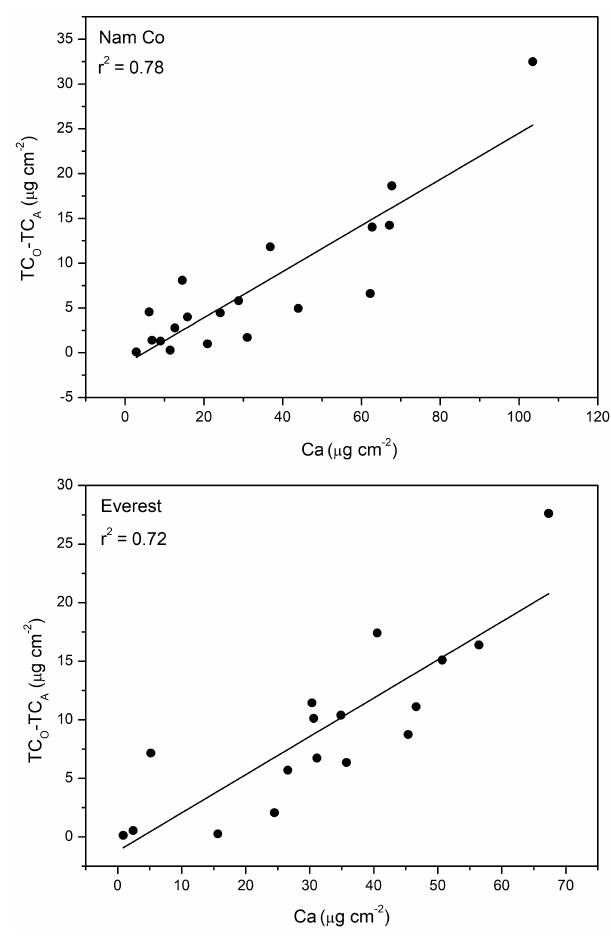
Figure 4. Relationship between aerosol IC and Ca at the Nam Co and Everest